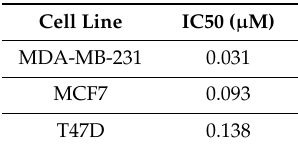
Table 1. IC50 ( µ M) values of ST09 for three breast cancer cell lines are tabulated for 48 h treatment. Cell